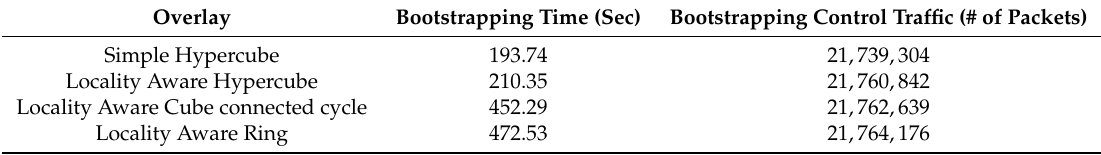
Table 2. Network bootstrapping time and traffic for different overlays, each overlay by 10 4